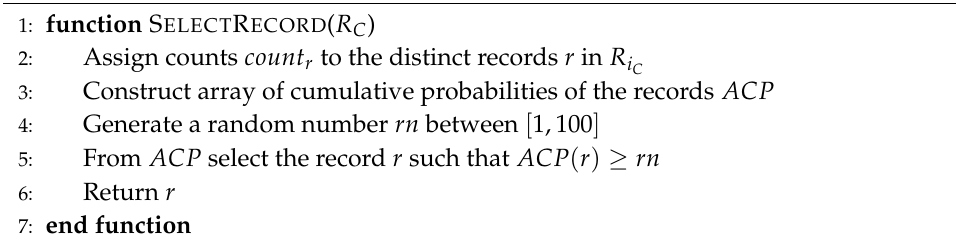
Algorithm 6 SelectRecord